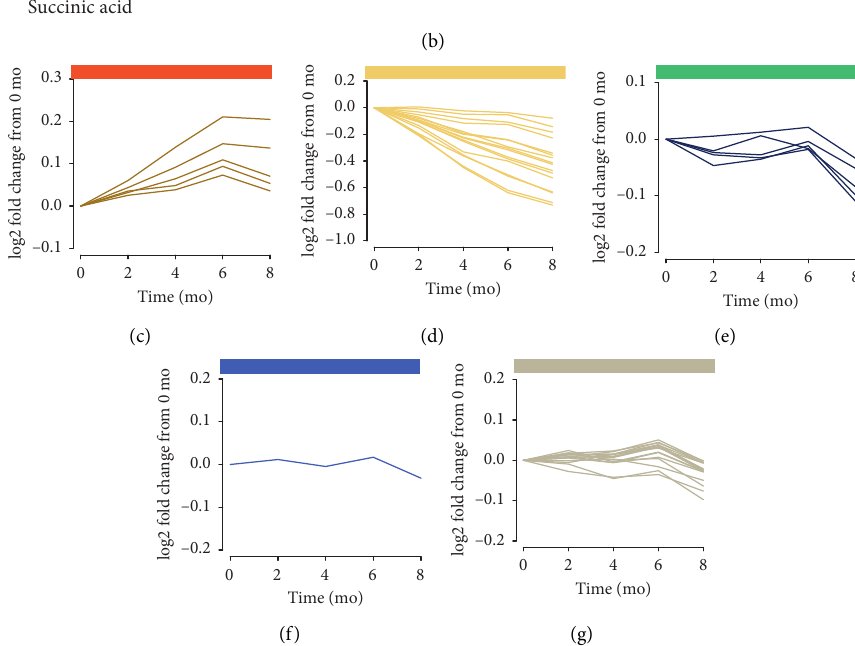
Figure 2: Heat map of correlations between sensory terms affected by storage time and metabolites. Heat coloring denotes the strength and direction of the correlation based on the Kendall correlation coefficient scale. Metabolites with significant correlations ( p < 0 . 05) to one or more sensory terms were split into five groups based on hierarchical clustering denoted by the color bars orange, yellow, green, blue, and gray. Sensory variables were similarly grouped by hierarchal clustering based on correlations with metabolites (a). Identified metabolites associated within each hierarchical cluster (b). Unidentified features are not listed and sugar molecules are only confidently assigned at a molecular class level and are differentiated by chromatographic retention time. For each cluster, the changes in abundance for cluster members (molecules) are plotted over time as log2 of the fold change from time 0 month (c–g). The members of the yellow cluster have the greatest change over